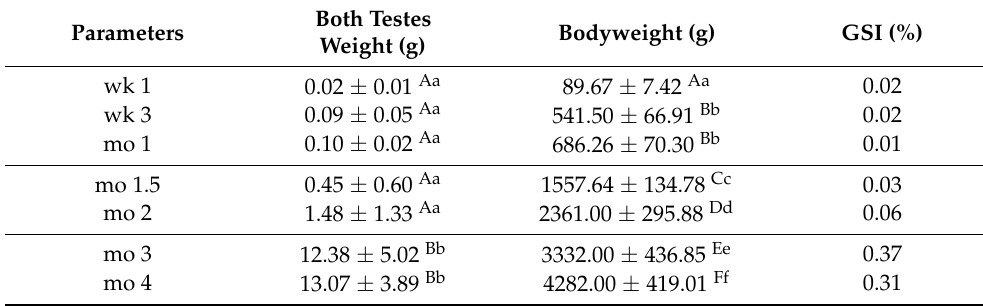
Table 1. Gonadosomatic index (GSI) of the growing chicks (Mean ± SD). Both Parameters